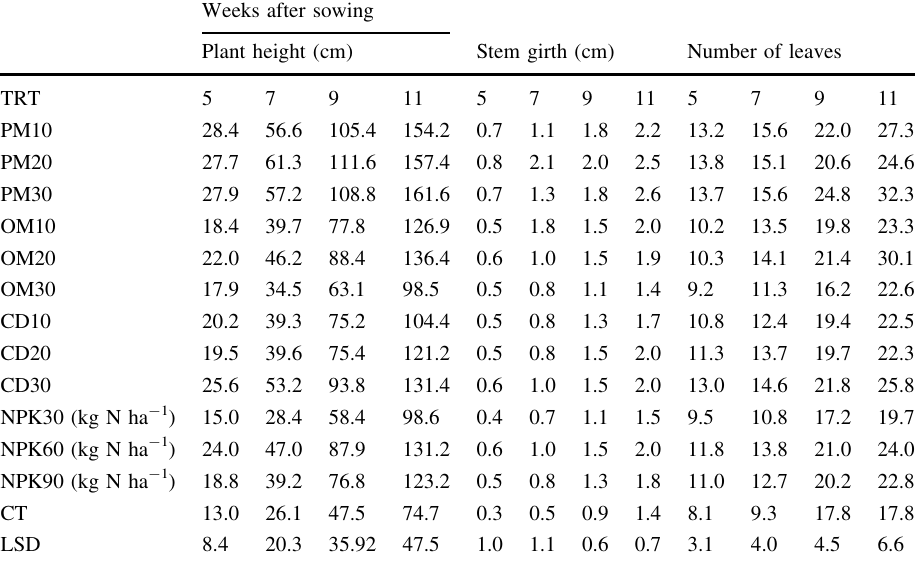
Weeks after sowing Plant height (cm)